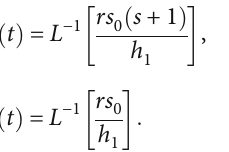
(d) errors for β = − 0 : 6 ð 0 Þ = 0 : 2 , y ð 0 Þ = 0 : 1 , z ð 0 Þ = 0 : 2 , x ð 0 Þ = 0 : 1 , y ð 0 Þ = 0 : 1 , and z ð 0 Þ = 0 : 1 1 1 2 2 1 2